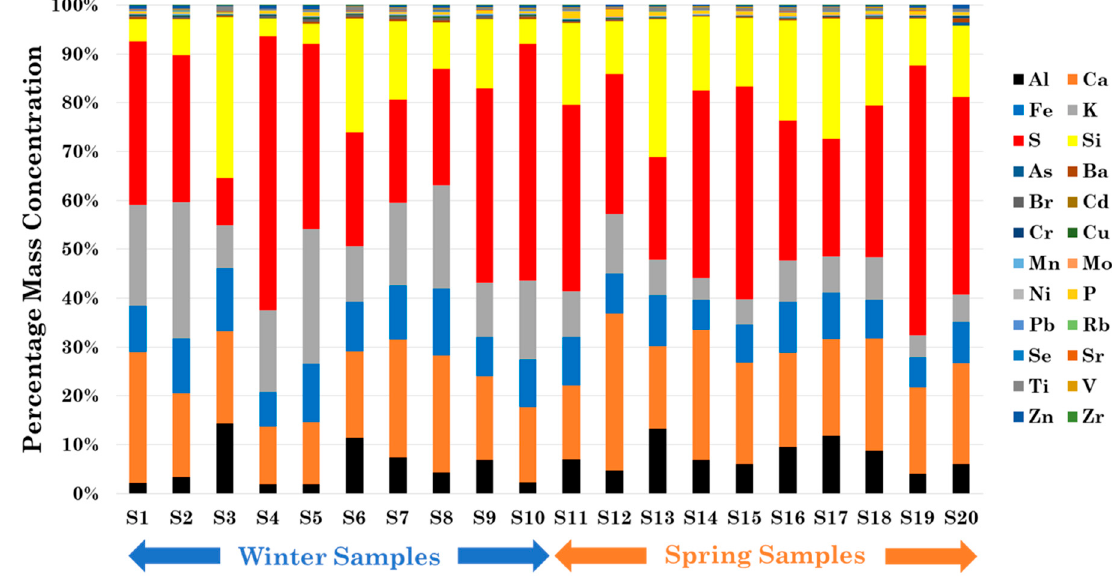
Figure 1. Bar plot of the mass concentration percentages of the investigated chemical elements in the 20 analyzed samples (S1–S10 in winter and S11–S20 in spring). The reported percentages are referred to the total sampled mass of all the 24 analyzed chemical elements. Table 1. Clustering of the 20 PM10 samples analyzed in this study, according to Romano et al. [45]. Main pollution sources and corresponding chemical fingerprints (according to the Chow [42] classification) are also